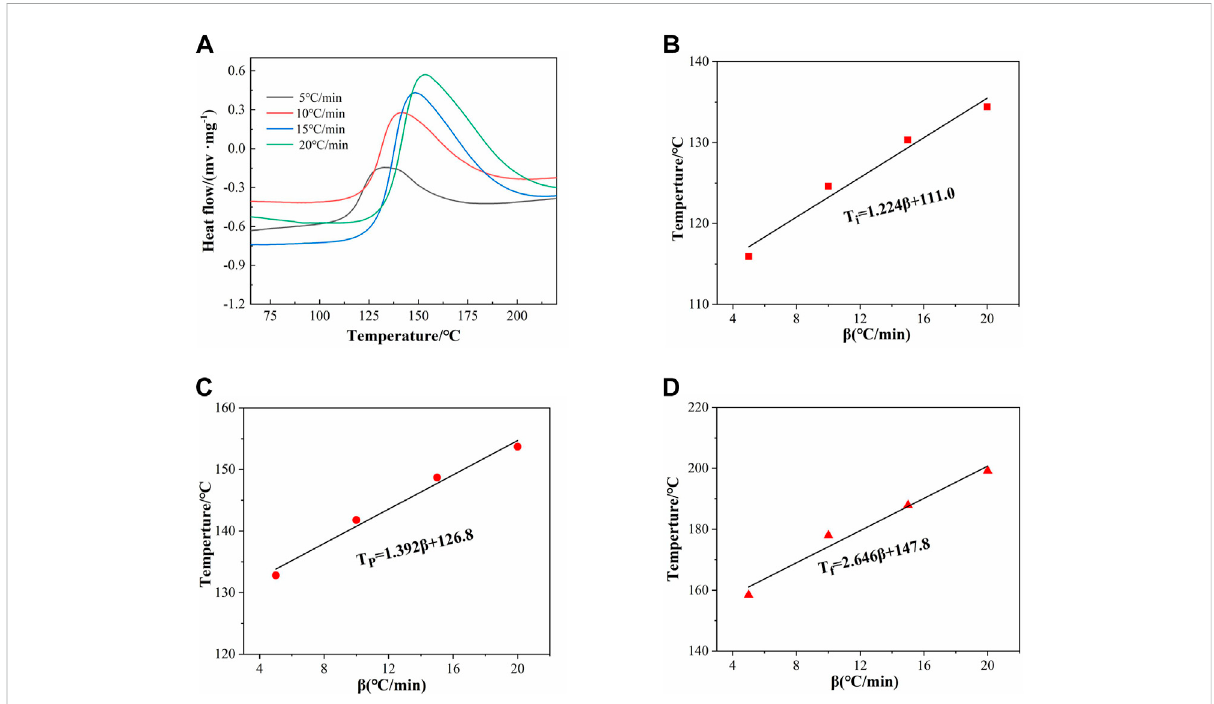
FIGURE 4 Resincuringkineticparameters (A) DSCcurvesofVBOresinsystem; (B) Theextrapolationplotof β -T i ; (C) Theextrapolationplotof β -T p ; (D) The extrapolation plot of β -T f